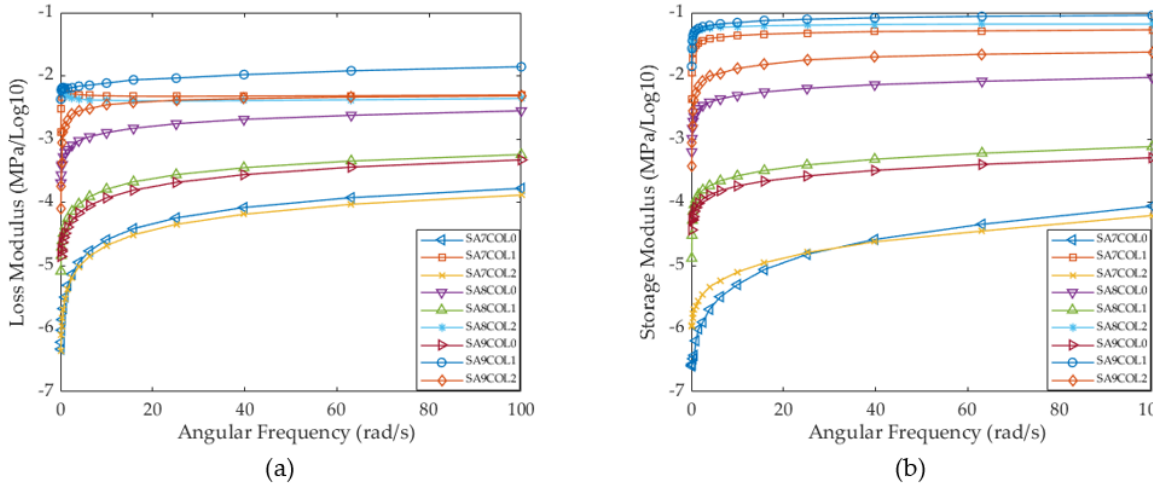
Figure 3. ( a ) Storage modulus (G ’ ) and ( b ) loss modulus (G ′′ ).